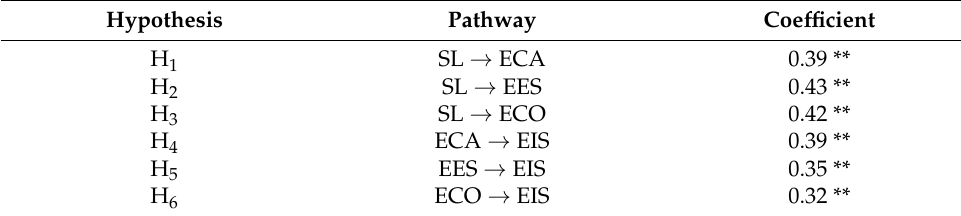
Table 3. The analysis results of the latent growth model.